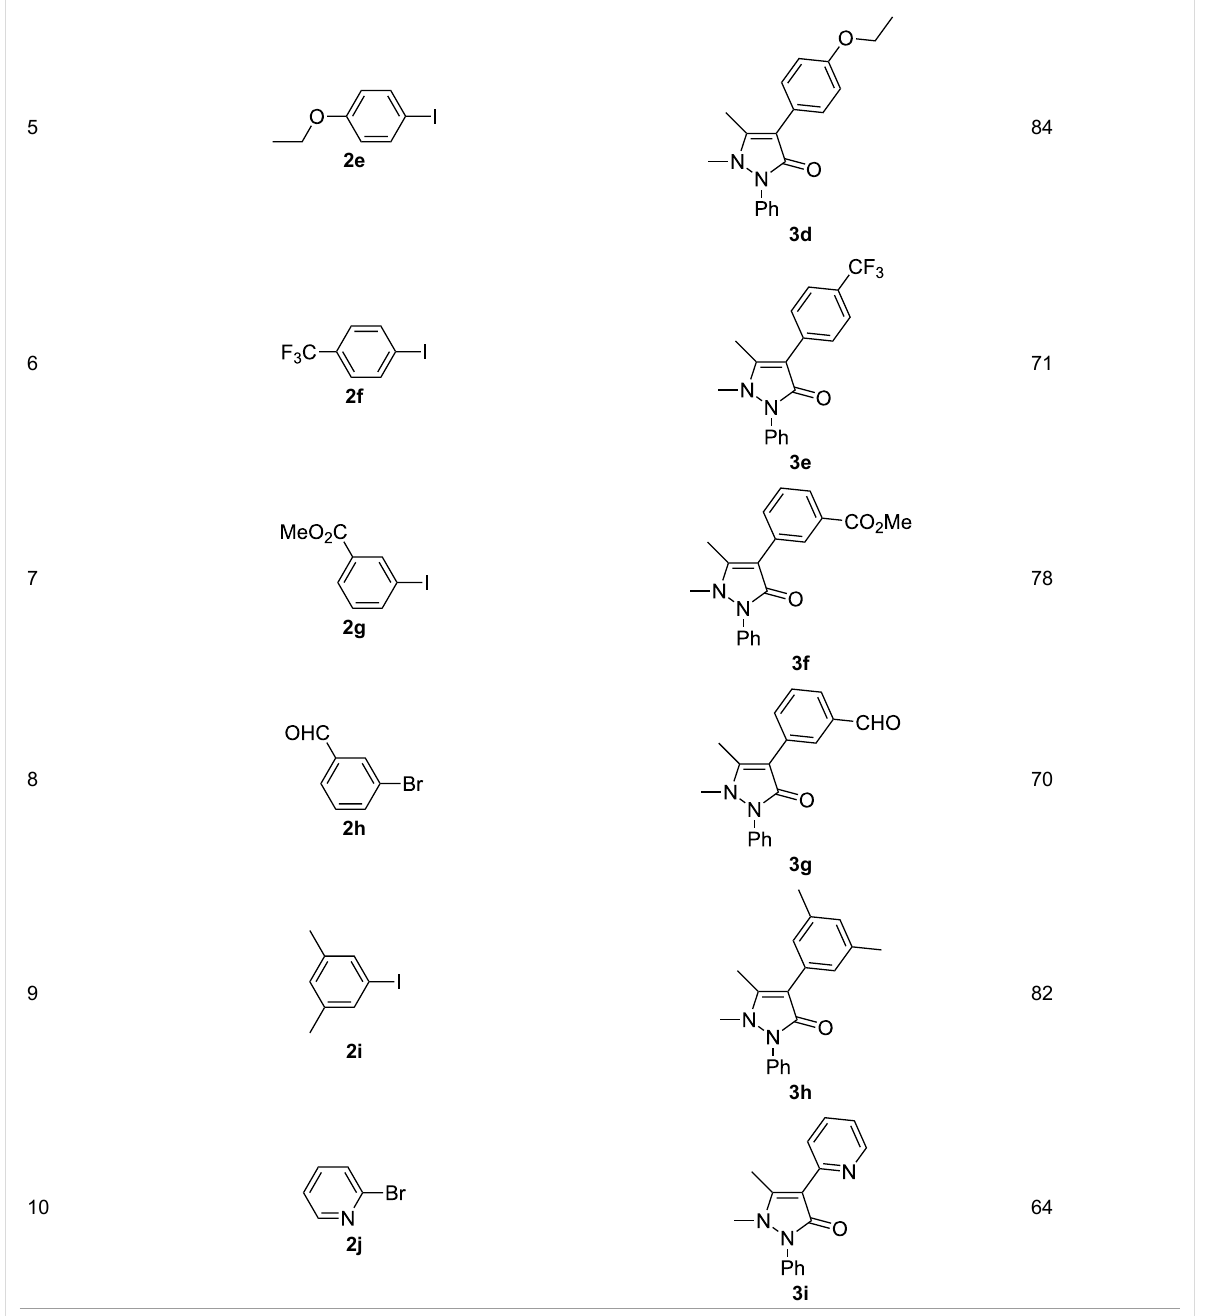
Table 2: Synthesis of 4-aryl- 5-pyrazolones 3 .